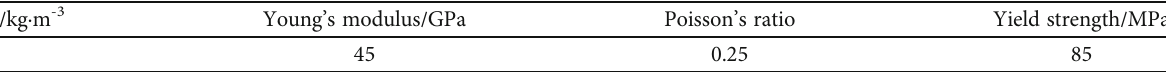
Figure 8: LS-DYNA 3D numerical model. Table 2: Calculation parameters of the rock surrounding the